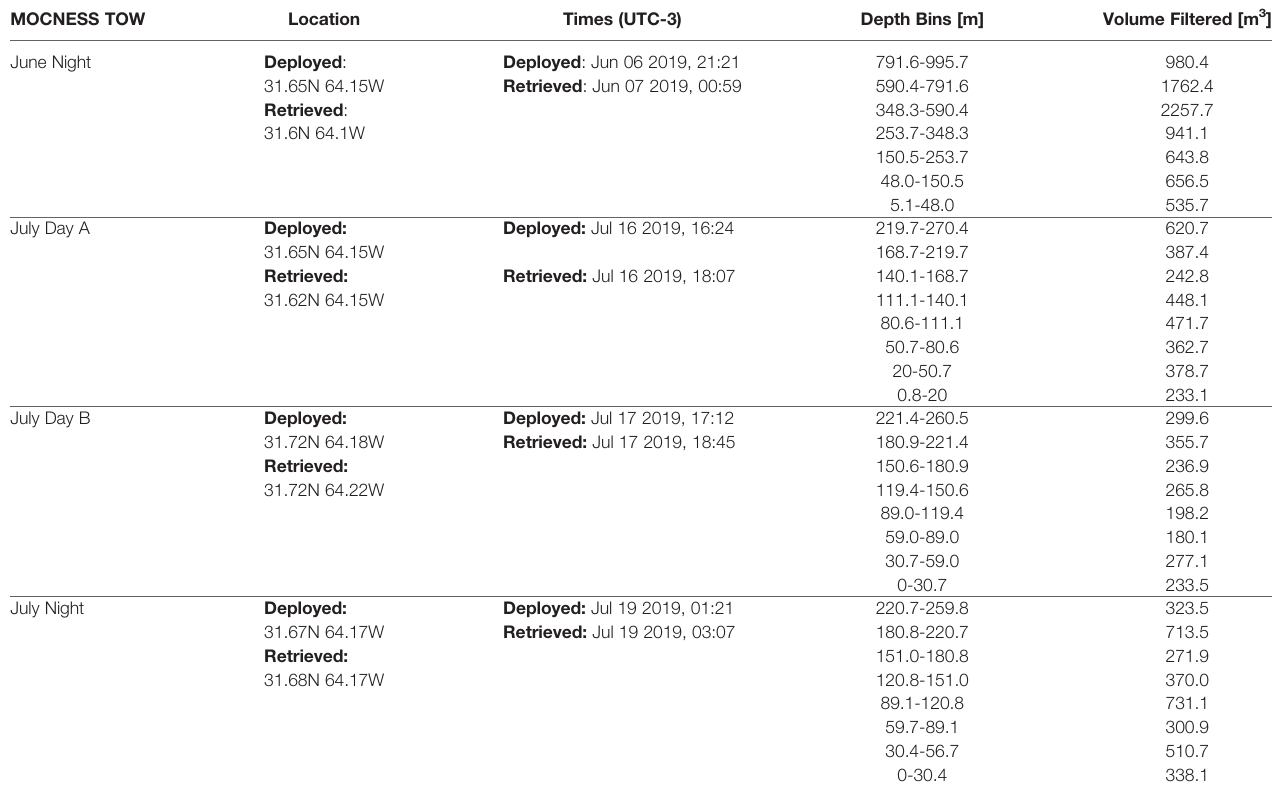
TABLE 2 | MOCNESS metadata for the four